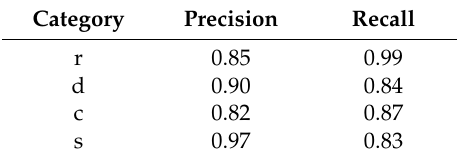
Table 5. Precision and recall for each food category after applying the post-processing